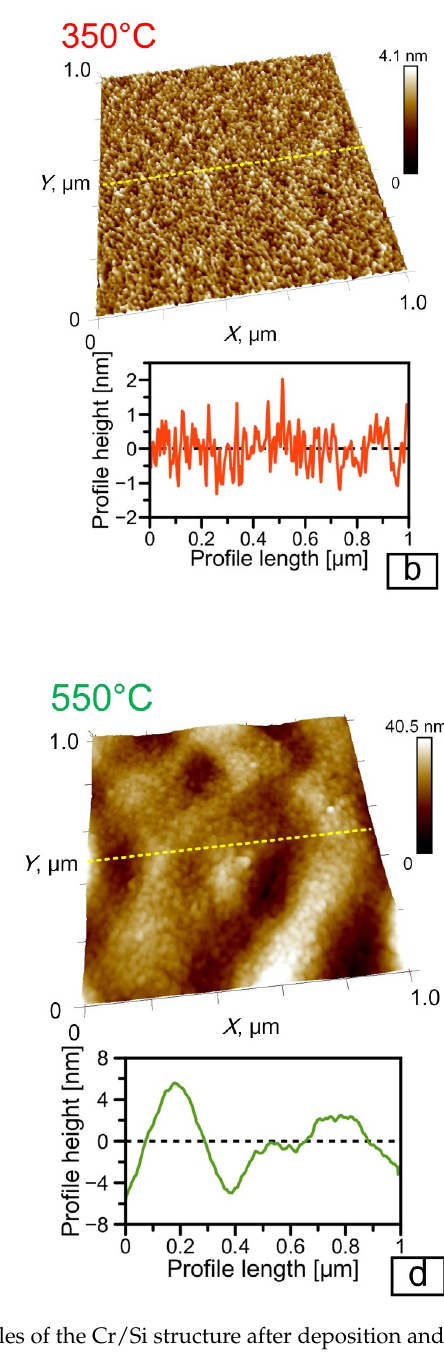
Figure 3. Morphology and the surface nanoprofiles of the Cr/Si structure after deposition and rapid thermal treatment: ( a ) initial film; ( b ) at the temperature of 350 ° С ; ( c ) at the temperature of 400 ° С ; ( d ) at the temperature of 550 ° С .